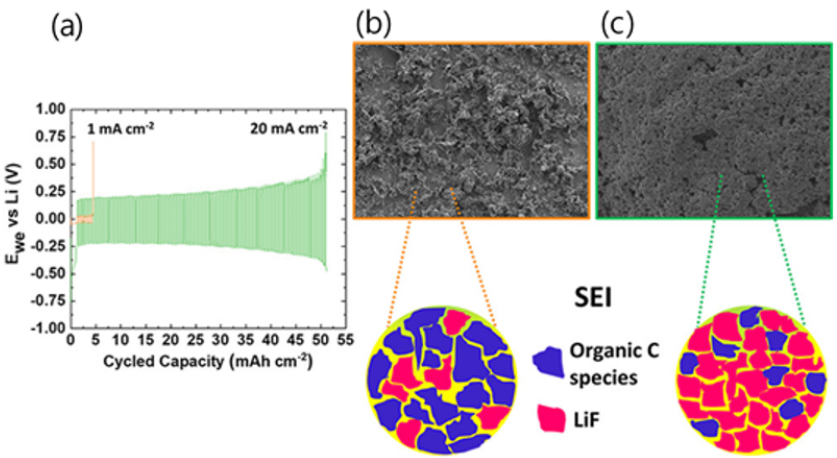
Figure 3. ( a ) Symmetric voltage profile at different current densities; ( b ) SEM images of deposited lithium at 1 mA cm − 2 ; ( c ) SEM image of deposited lithium at 20 mA cm − 2 . Reprinted 2020 from [78] with permission from American Chemical Society.